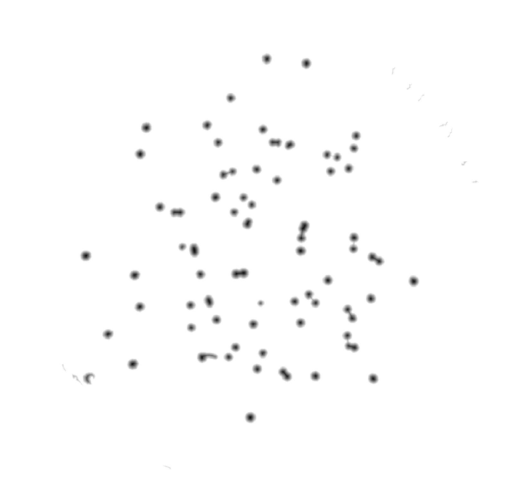
Figure 13. Negative of distance transform image result.